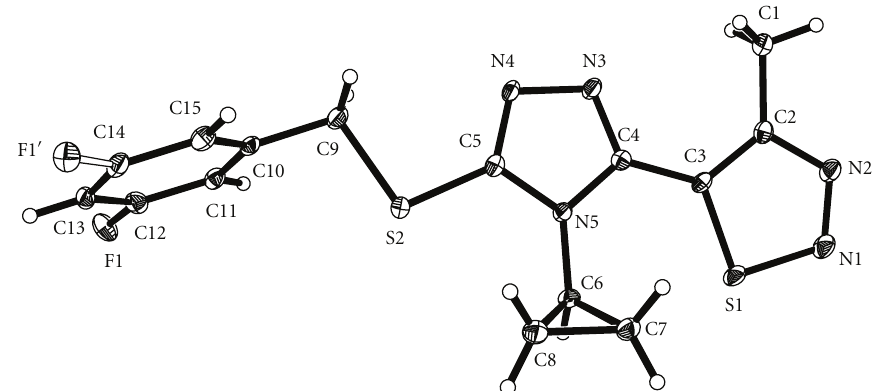
F 1: Molecular structure of the title compound, showing displacement ellipsoids drawn at the 30